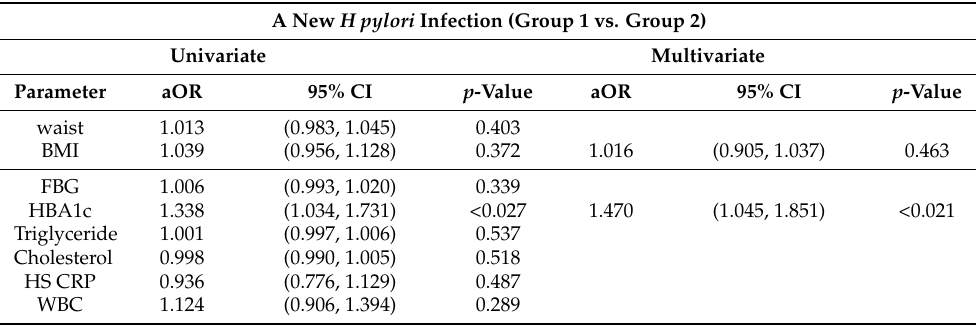
Table 2. Factors associated with H. pylori infection status change by logistical regression